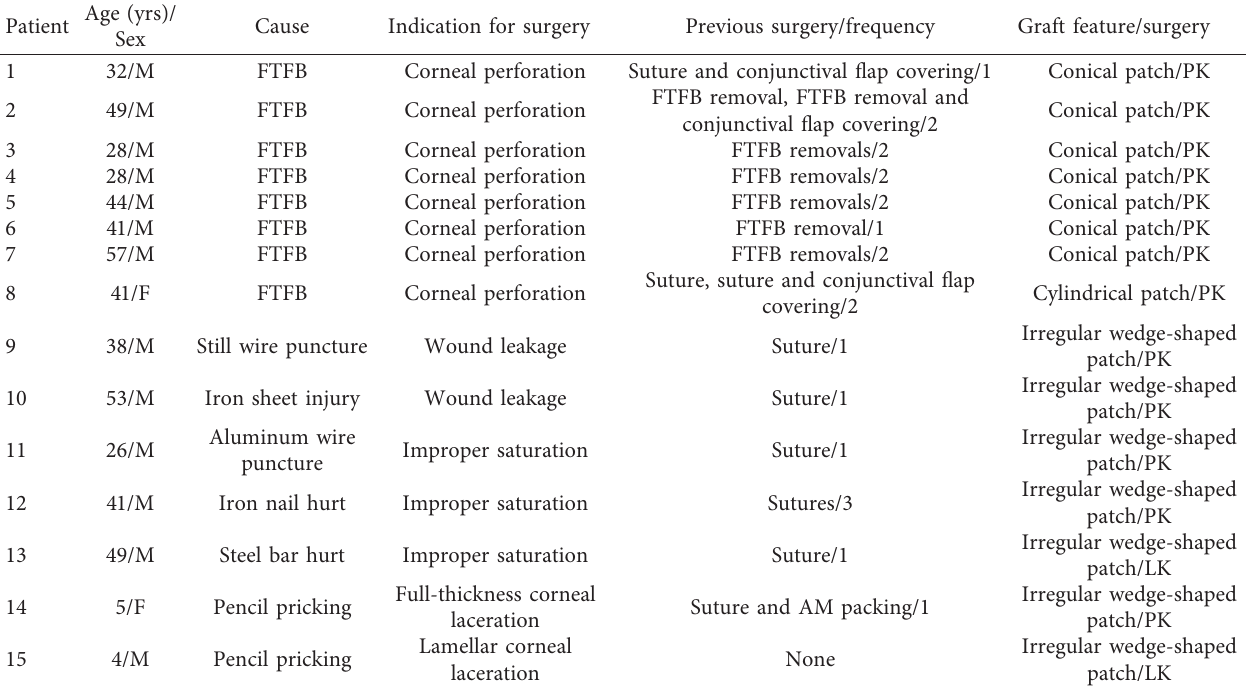
Table 1: Summary of clinical